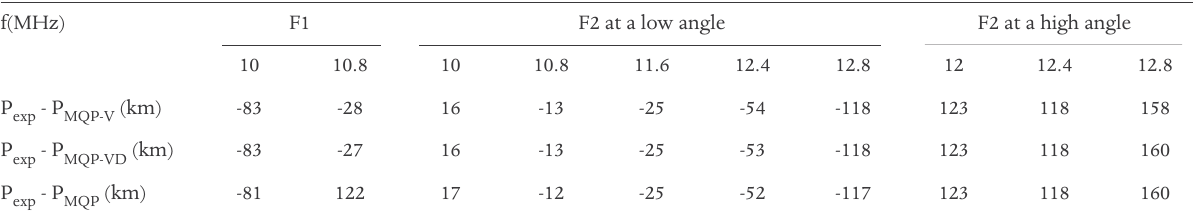
Table 3. Difference values in the one-hop group paths of the experimental oblique sounding and of the simulation results. Time: May 25, 2014, at